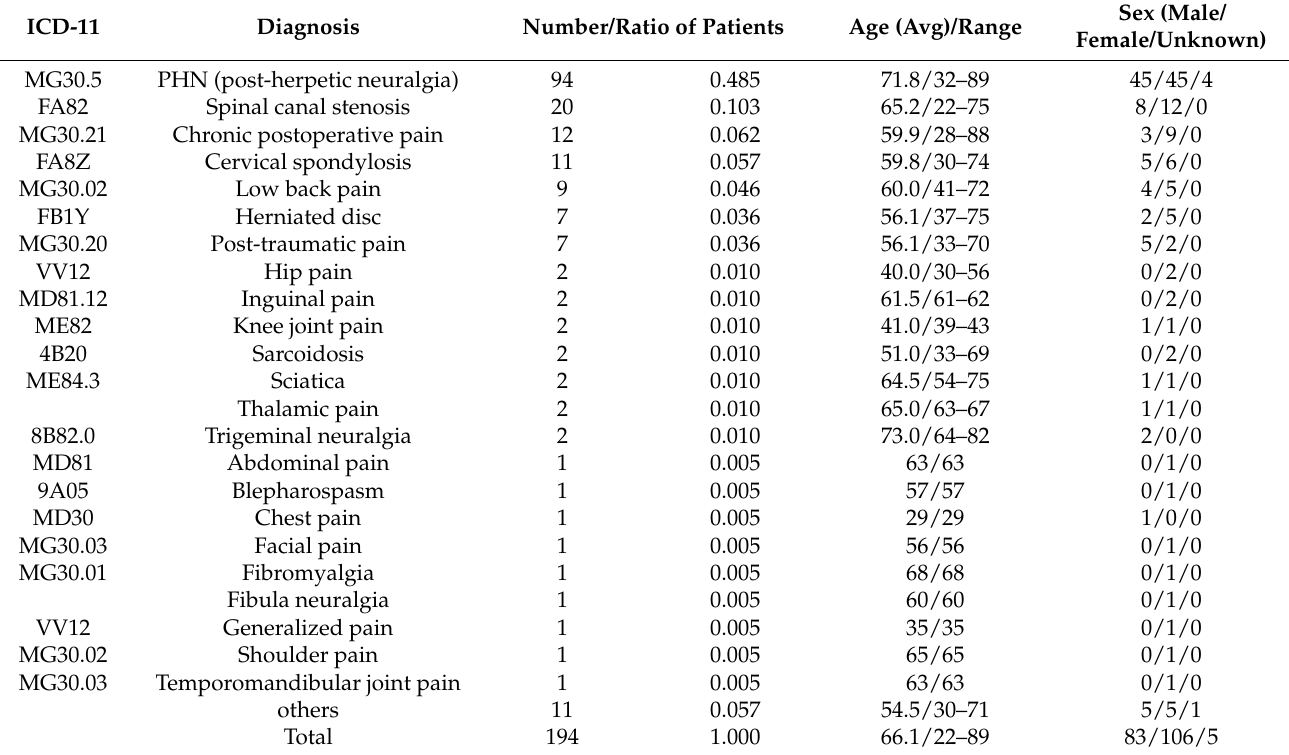
Table 3. Distribution of the main diagnostic names and number/ratio of